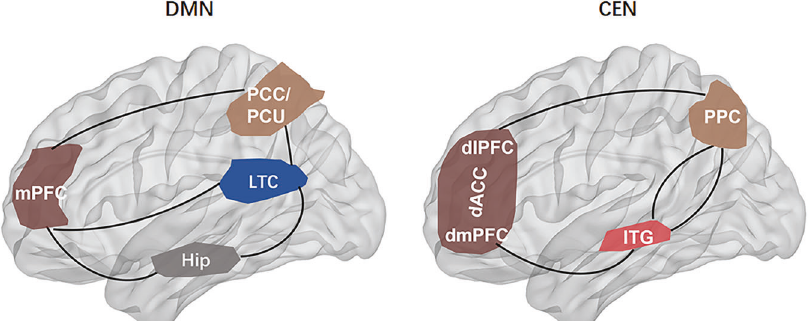
Fig. 3 The default mode network extending from the prefrontal medial cortex (mPFC) to the posterior cingulate cortex (PCC), PCU precuneus cortex, lateral temporal cortex (LTC), temporal pole (TempP), hippocampus (Hip) is involved in, respectively, in multiple